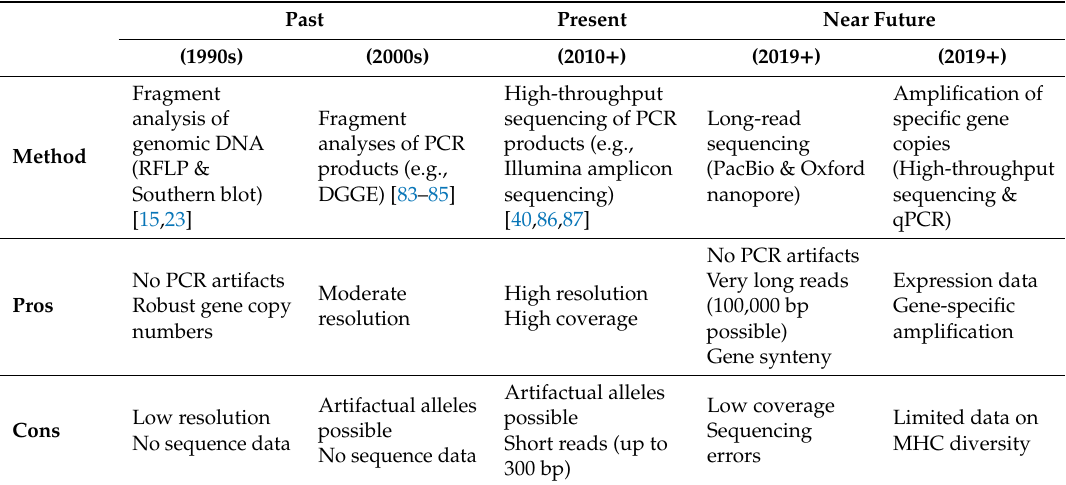
Table 1. The development of major histocompatibility complex (MHC) genotyping methods in birds over four decades, with the advantages (Pros) and disadvantages (Cons) associated with di ff erent methods and future